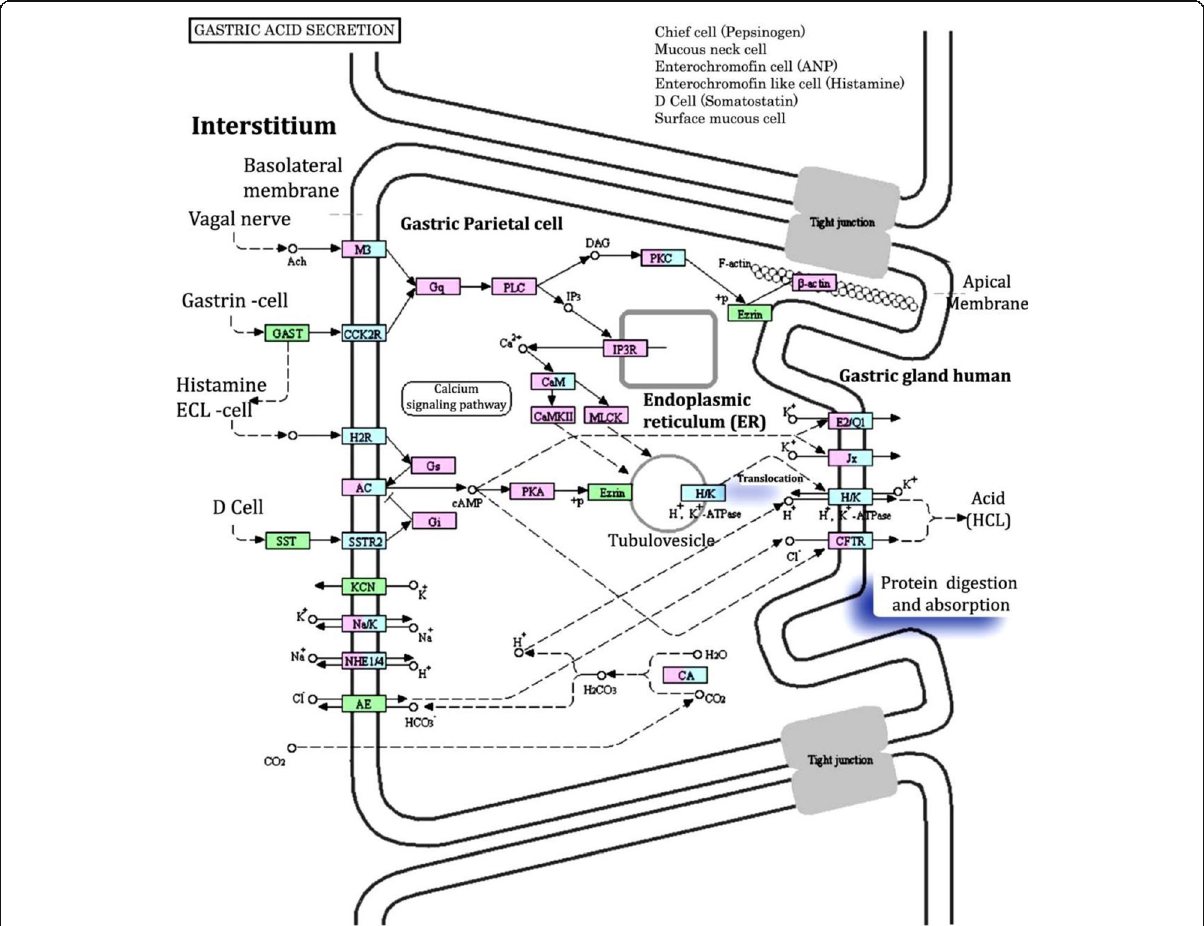
Fig. 2 Human gastric acid secretion pathways that serve the drug target site for curing ulcer activity (pink indicates diseased gene and blue indicates drug target